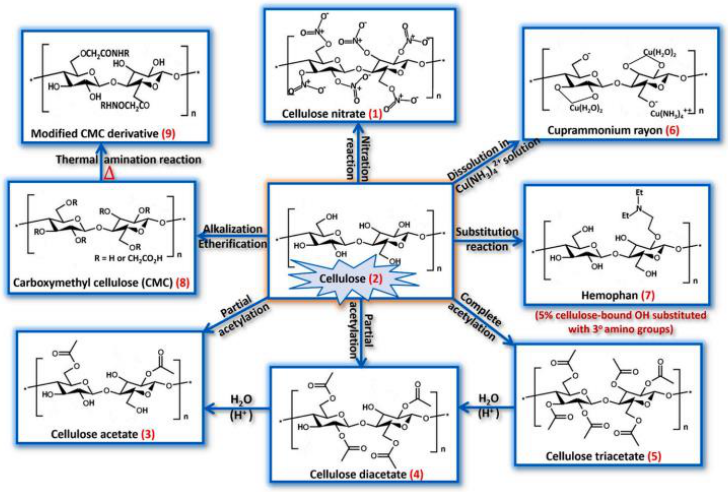
Figure 2. Molecular structures of cellulose and some cellulose derivatives (reproduced with permis- sion after [65] ).